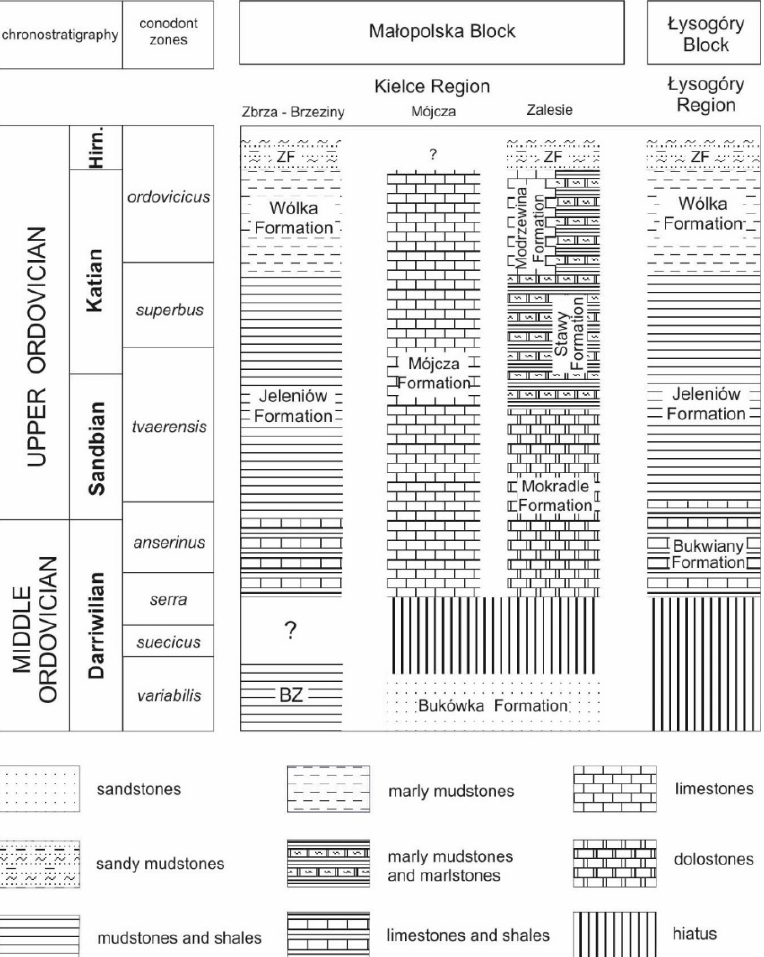
Figure 2. Lithostratigraphy of the upper Middle and Upper Ordovician, and general facies layout in the HCMts (compiled from Trela [41–43]; conodont zones after Dzik [44,45]. Hirn—Hirnantian, BZ—Brzeziny Formation, ZF—Zalesie